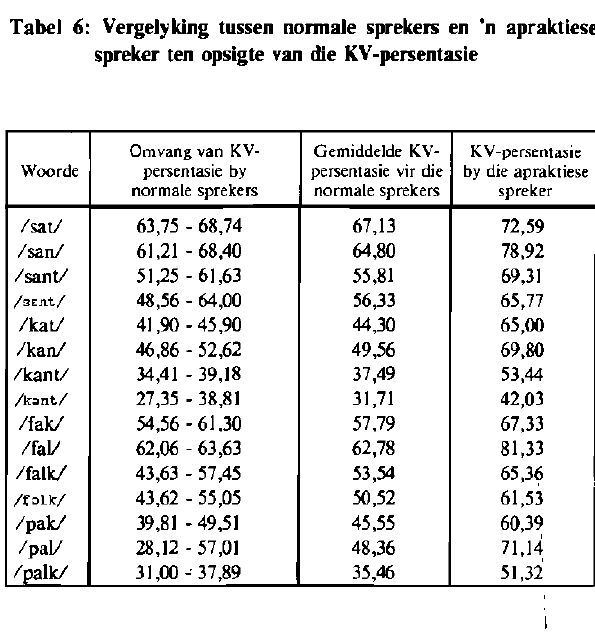
AP = Apraktiese proefpersoon. Woorde